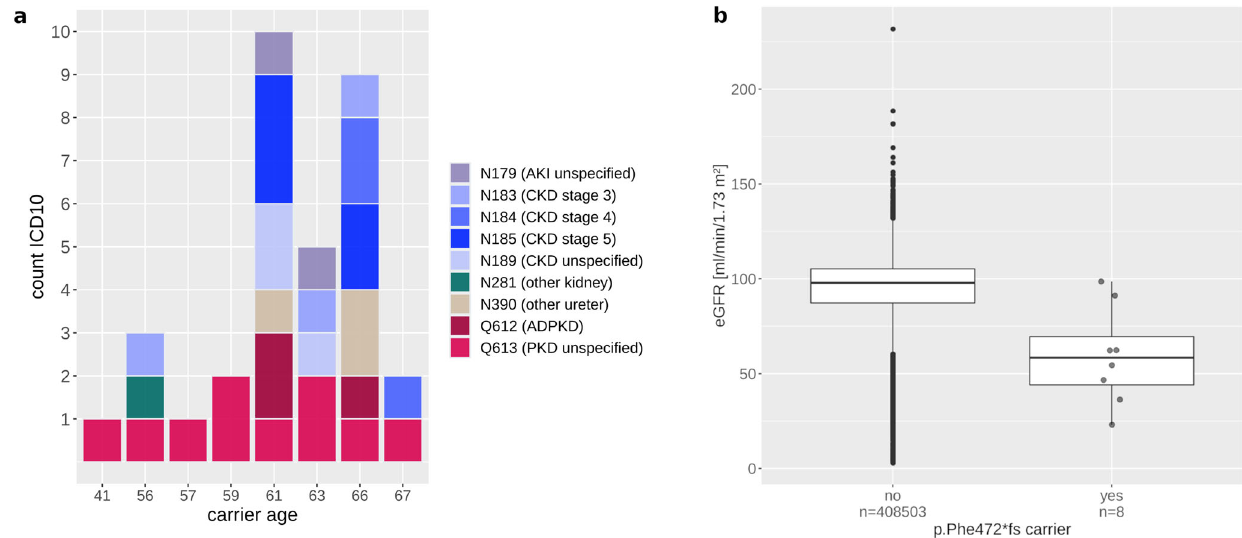
Fig. 2 | Details for carriers of the PKD2 p.Phe472*fs variant. a Kidney ICD10 diagnosis by the carrier, color-coded (red — cystic kidney disease codes, blue — CKD codes). Carrier age was annotated in the columns. The median age was 60 (range 41 – 67). b Boxplot of eGFRcrea for the non-carriers of the